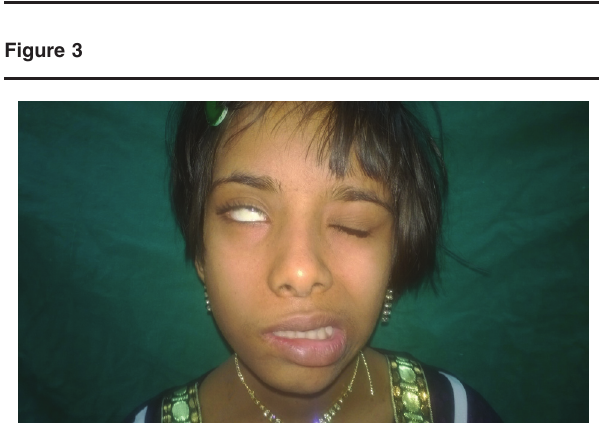
HRCT of the temporal bone axial cuts showing tumour with exten- sions.